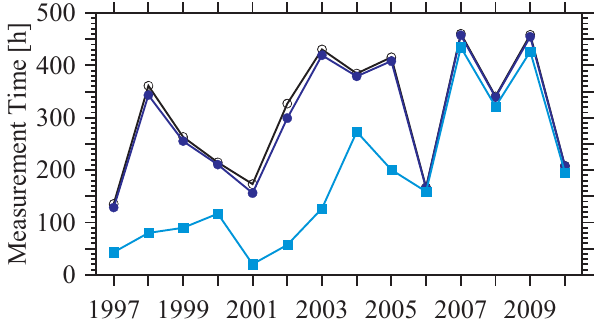
Fig. 1. Measurement times of the ALOMAR RMR-lidar during the NLC season (1 June–15 August) for different data sets: en- tire (black hollow circles), long-term (blue filled circles) and high- sensitivity (light blue filled squares). The last two data subsets con- tain only measurements with mean uncertainties of 1β NLC (z) < 4 × 10 − 10 m − 1 sr − 1 and 1β NLC (z) < 1 × 10 − 10 m − 1 sr − 1 , respec- tively, in the altitude range from 80 to